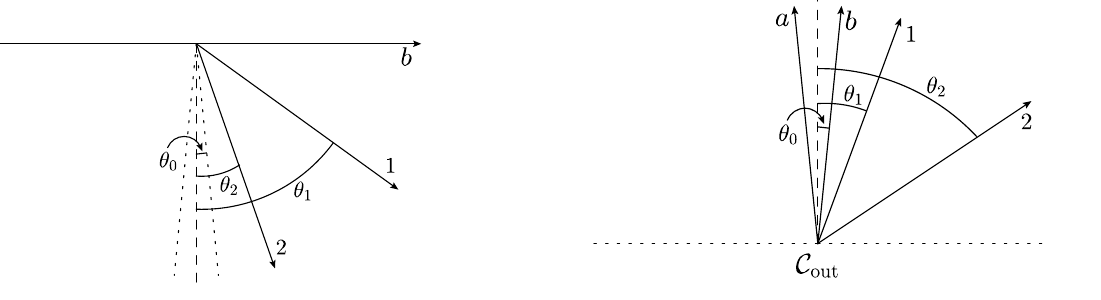
Figure 2 . Di-jet set-ups giving rise to double non-global logarithms. The original partons initiating the two jets are denoted with labels a and b respectively. Successive gluon emissions contributing to the double-logarithmic BMS evolution are indicated by numbers 1, 2, . . . . (gluon 2 being emitted after gluon 1 etc). Left: a pair of back-to-back jets in the COM frame; the exclusion region C out has a small opening angle (cid:18) 0 (cid:28) 1 around an axis perpendicular to the jet axis. Right: a pair of boosted jets making a small relative angle (cid:18) 0 (cid:28) 1; the exclusion region C out occupies the whole backward